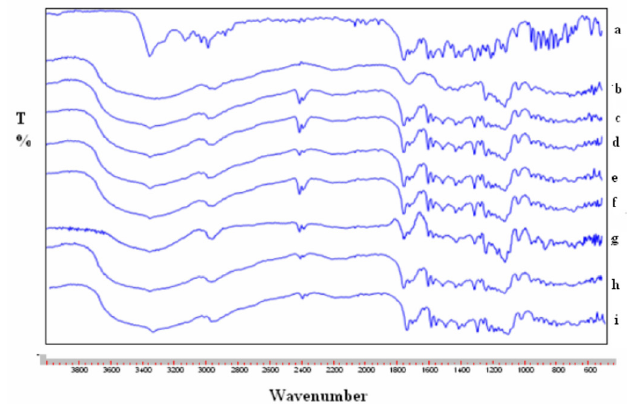
FIGURE 4 - IR spectral analysis of drug (a), β-CD (b), physical mixture (c) kneading method (d), coevaporation method (e), co-grounding (f), spray drying( g), melting method (h), freeze drying (i).